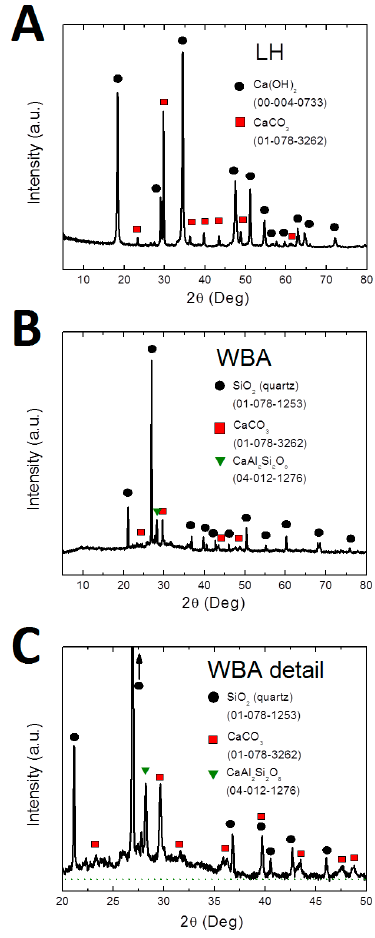
Figure 2. X-ray diffraction patterns. A) LH, B) WBA, C) detail of WBA. Figure 2. X-ray di ff raction patterns. ( A ) LH, ( B ) WBA, ( C ) detail of